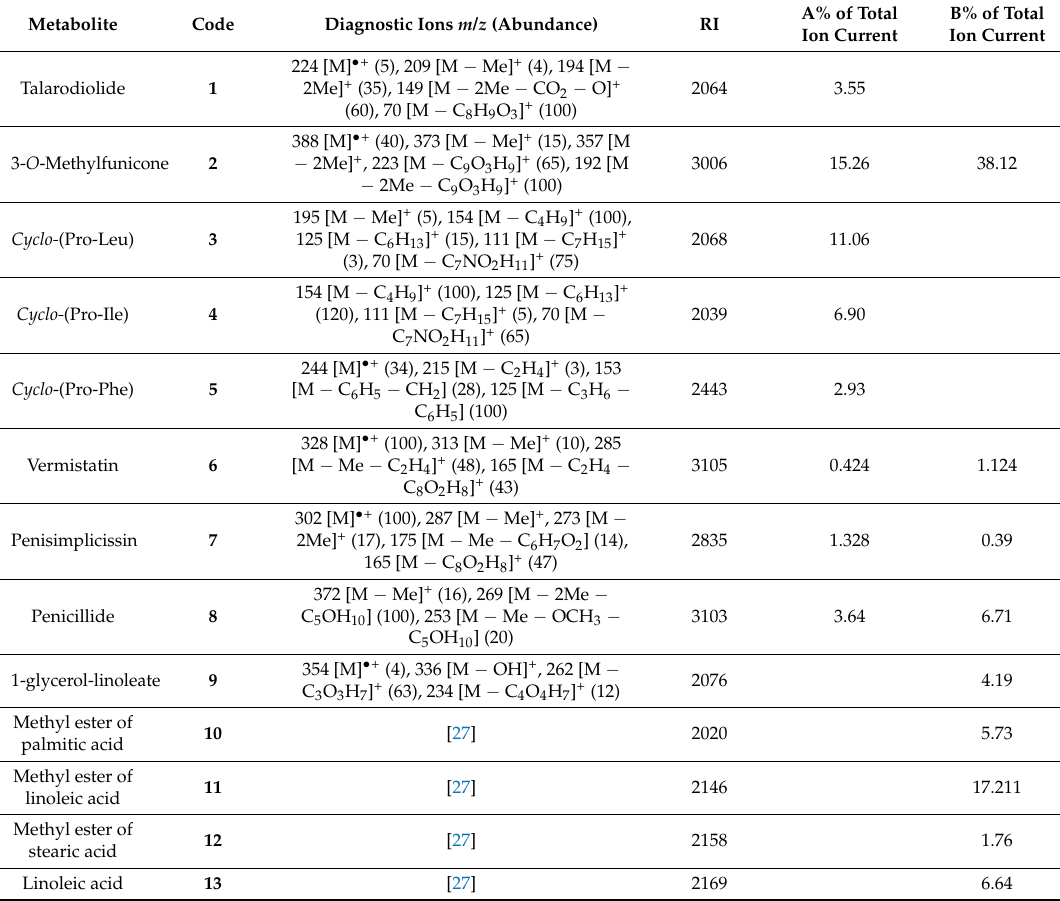
Table 2. GC/MS analysis of the crude extract of culture filtrate (A) and mycelium (B) of T. pinophilus LT6.